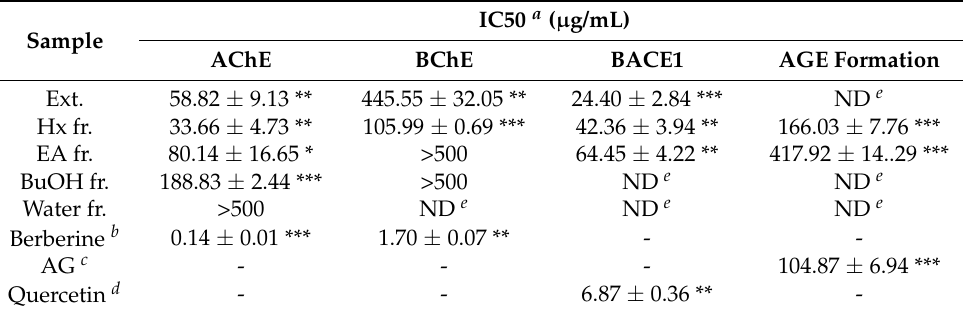
Table 2. IC 50 of the M. officinalis extracts and fractions for acetylcholinesterase (AChE), butyrylcholinesterase (BChE), β -site amyloid precursor protein cleaving enzyme 1 (BACE1), and advanced glycation end-product (AGE) formation. IC50 a ( µ g/mL) Sample AChE BChE BACE1 AGE Formation Ext. 58.82 ± 9.13